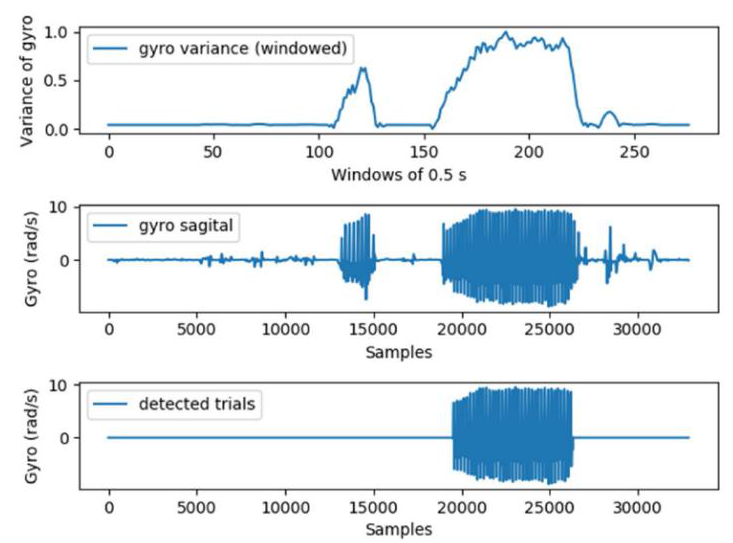
Figure 7. The running activity recognition algorithm. The figure in the middle depicts the input signal; the top figure shows the calculated variance in each of the 0.5 s windows in which the signal is split; the bottom figure displays the part of the signal that is detected as running. It is worth underlining that the first bout of activity shown in the figure is not detected as running since its duration is lower than the 20 s threshold.